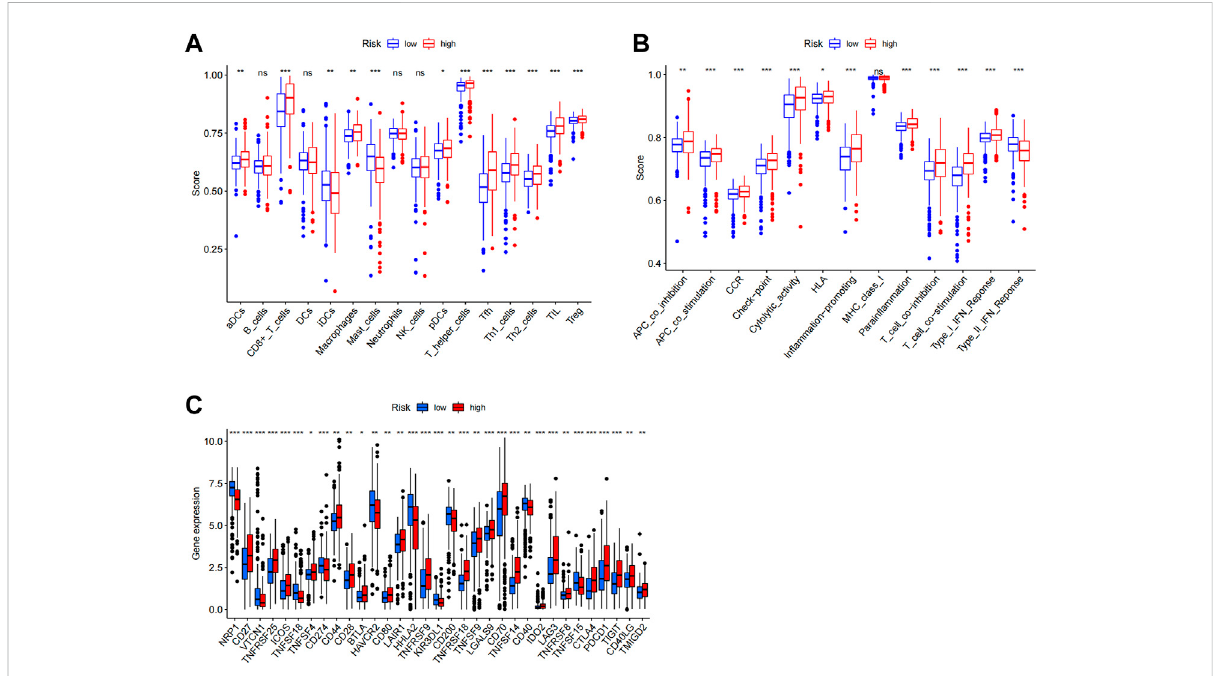
FIGURE 10 Immune in fi ltration analysis. ssGSEA score results. A, B Results for ssGSEA scores [immune cells scores (A) and immune functions scores (B )] between high andlow-risk groupsinboxplots. (C) Expression ofimmunecheckpoints among highand low-risk groups.ns notsigni fi cant;* p < 0.05; ** p <